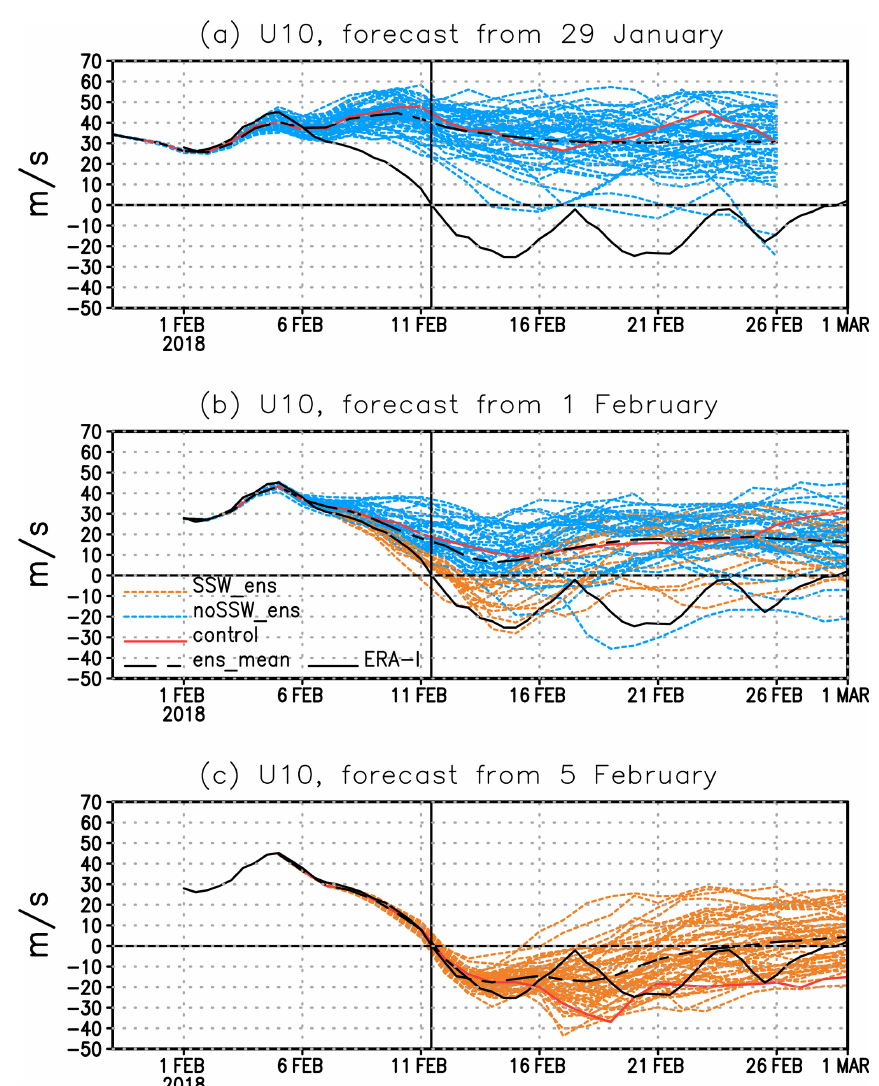
Figure 1. Zonal-mean zonal wind at 10hPa and 60 ◦ N (ms − 1 ). (a) Ensemble forecast initialized on 29 January; (b) ensemble forecast initialized on 1 February (orange lines denote ensemble members that predict wind reversal with max 1d delay, red line – control forecast, black dashed line – ensemble mean) and the ERA-I reanalysis (black solid line); (c) forecast initialized on 5 February. Vertical line denotes the SSW2018 central